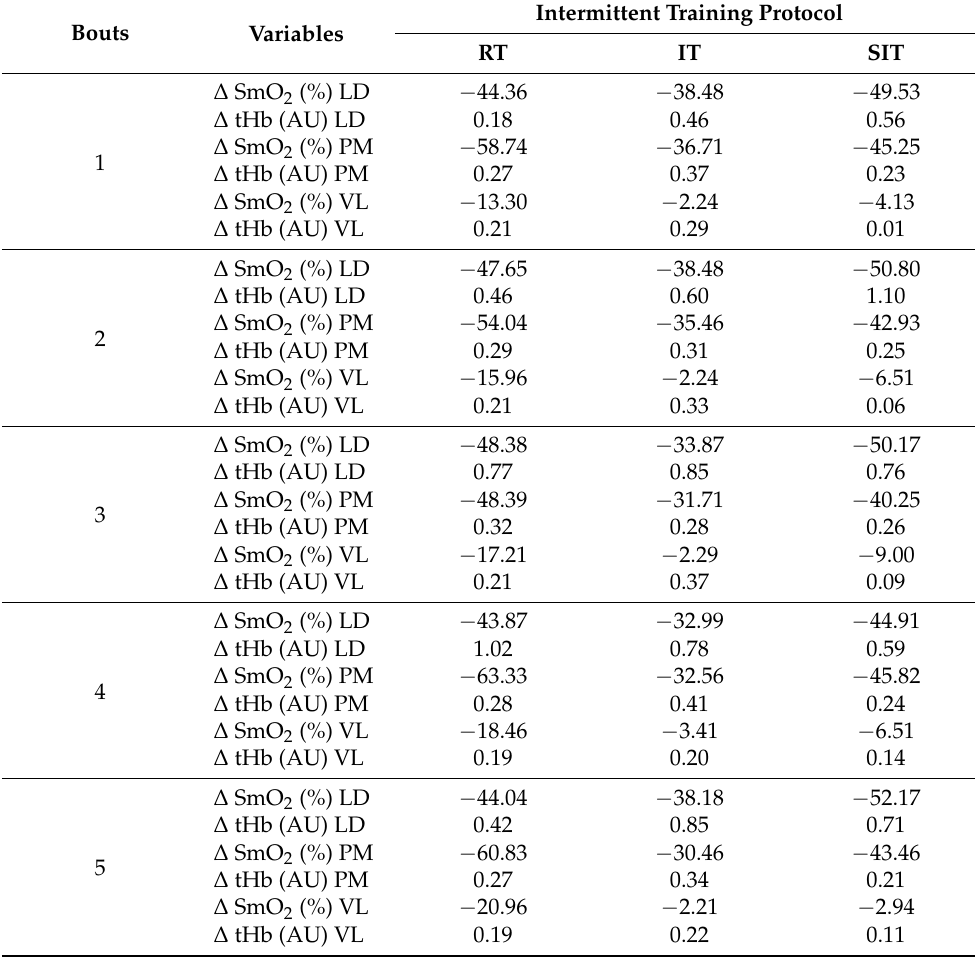
Table 5. Changes in ∆ SmO 2 (%) and ∆ tHb (AU) following different training protocols for each bout. Intermittent Training Bouts Variables